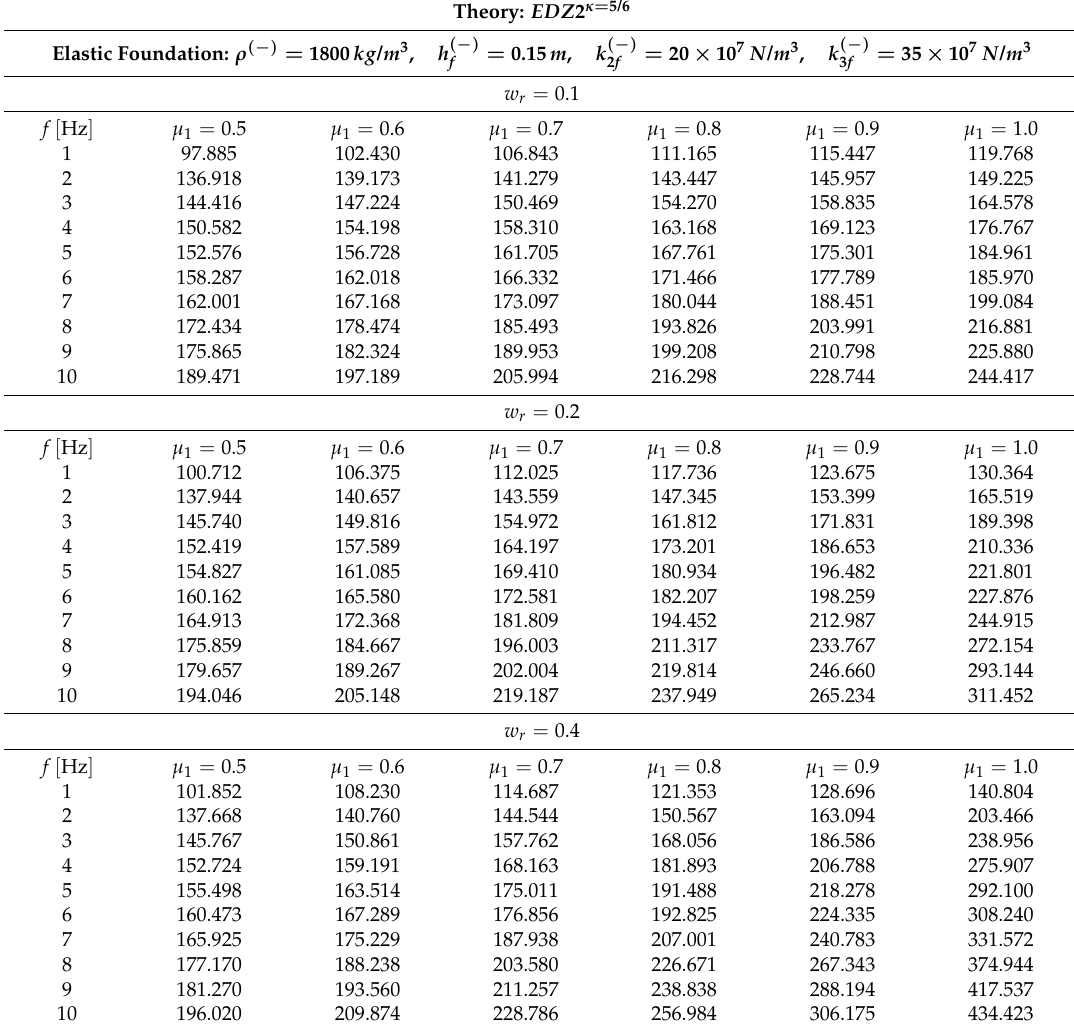
Table 13. First ten natural frequency variations for EDZ2 κ = 5/6 theory of a CCFF helicoidal surface (Figure 4c) reinforced by CNTs distributed as in Figure 5c for different mass fractions w r when varying the parameter of agglomeration µ 1 with µ 2 = 1. The Chebyshev-Gauss-Lobatto grid distribution was employed, with I N = 31, I M =